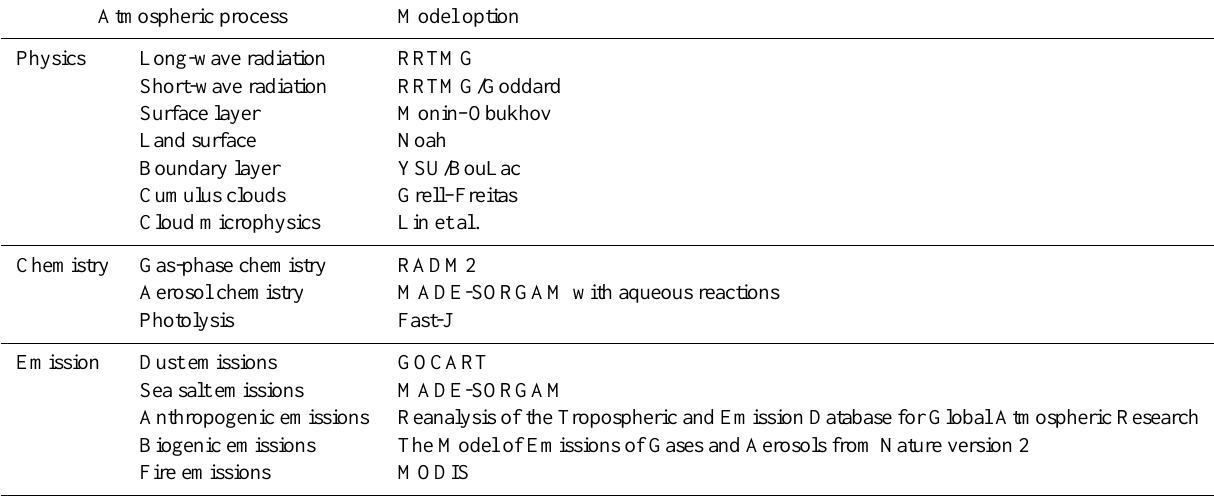
Table 1. Configuration options of WRF-Chem used in this